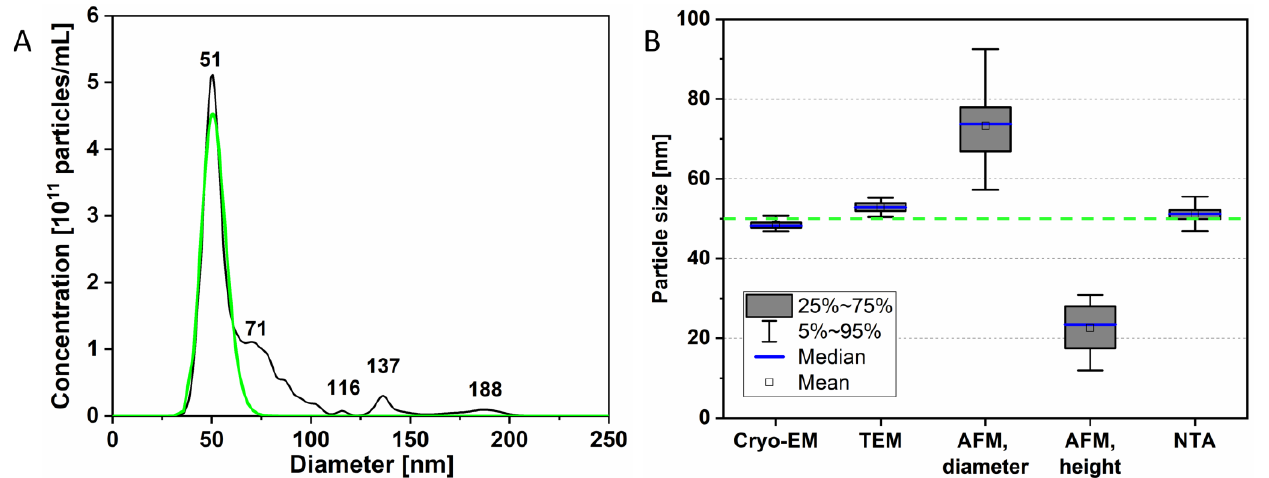
Figure 2. Comparison of TBEV particle sizes. ( A ) Distribution of the hydrodynamic size of TBEV obtained using the nanoparticle tracking analysis (NTA)—black line, and the approximation of the first peak using a log-normal function—green line. ( B ) Comparison of virion size data obtained within this study. The green dashed line in ( B ) shows the mean diameter of the virions according to literature data